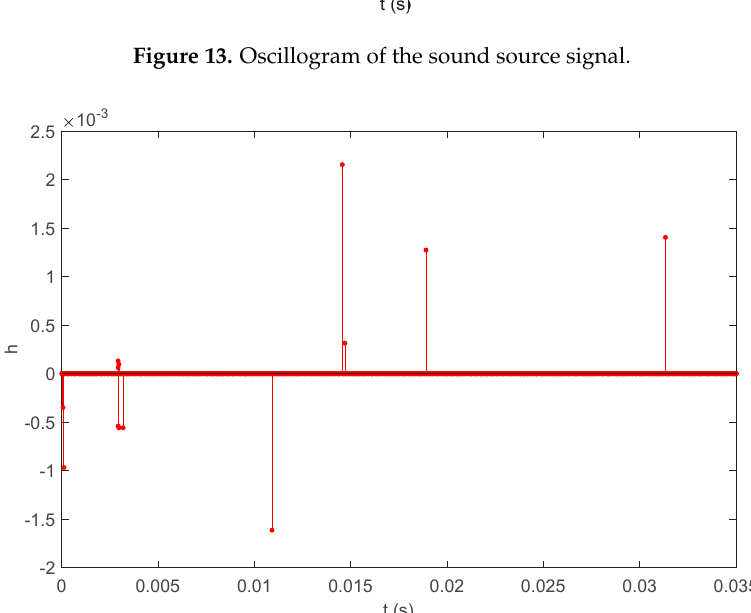
Figure 14. Unit impulse response h(t)